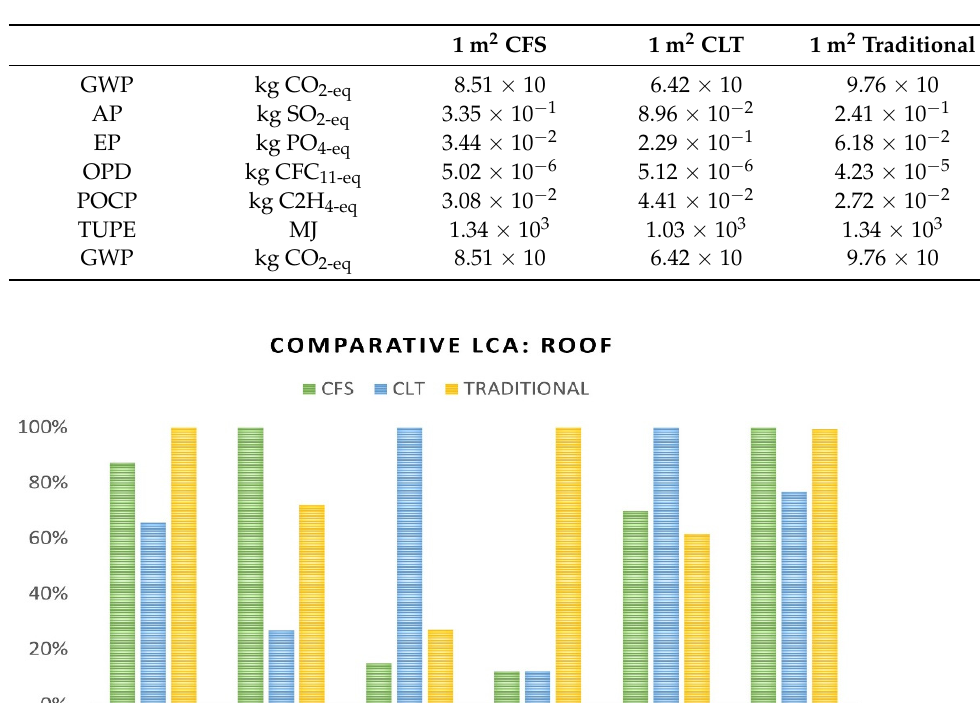
Figure 15. Results of Life Cycle impact assessment: External Wall. Table 18. LCA results: roof.